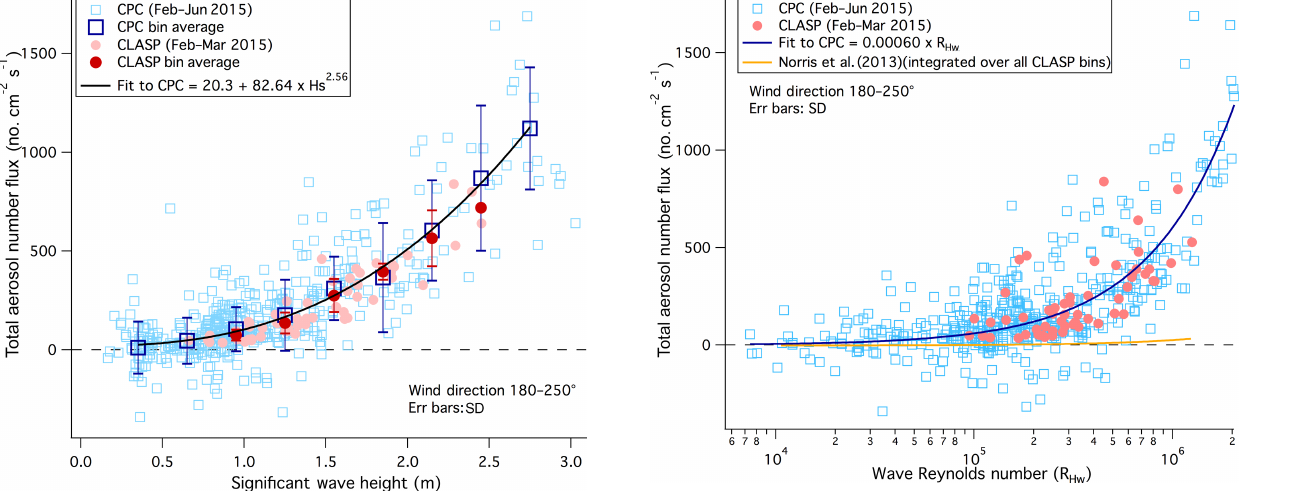
Figure 6. Hourly total aerosol number source fluxes from the CPC and CLASP vs. significant wave height (data from 2015).